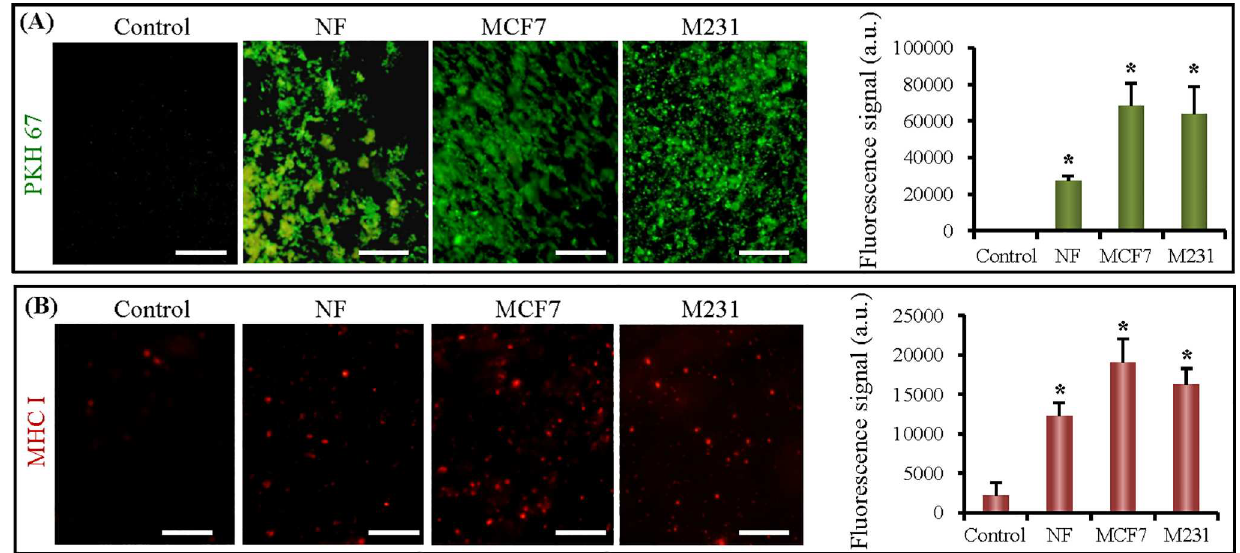
Fig 3. Microfluidic immunomagnetic capture and detection from cell culture medium. (A) Images and quantification of total exosomes from control and CM of NF, MCF7 and M231. Exosomes were stained by PKH67. (B) Images of and quantification of MHC I-positive exosomes from control and CM of NF, MCF7 and M231. * , p < 0.05. The scale bars represent 50 μ